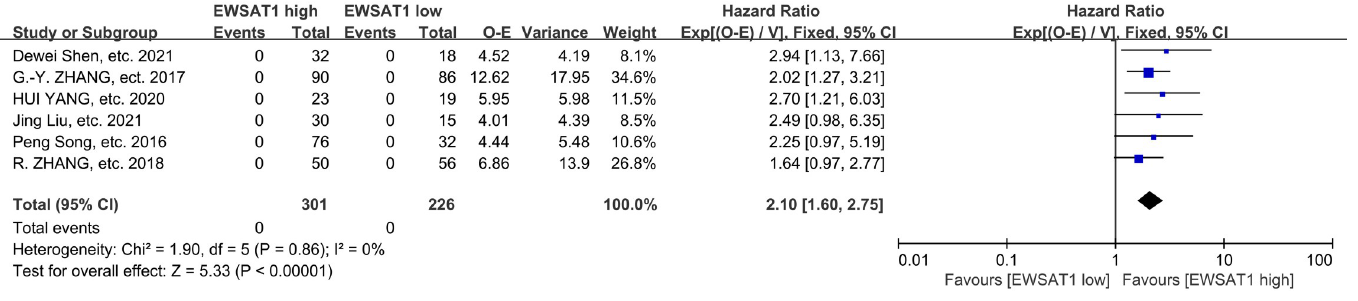
Fig 2. Forest plot for the association of EWSAT1 expression with overall survival.